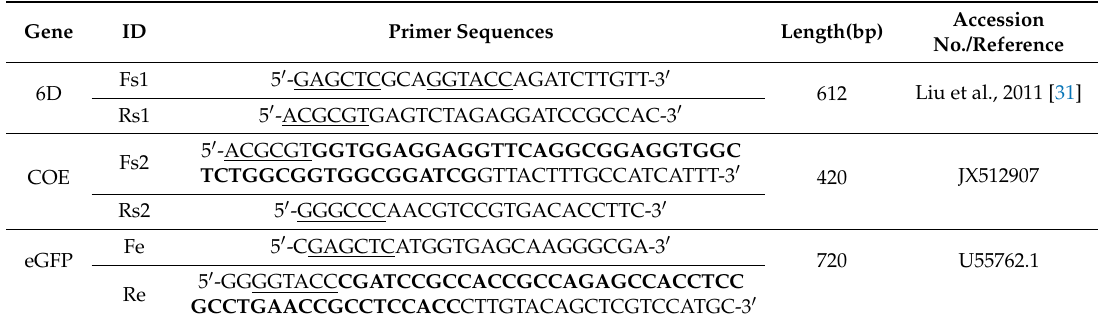
Table 2. Details of primers used in this